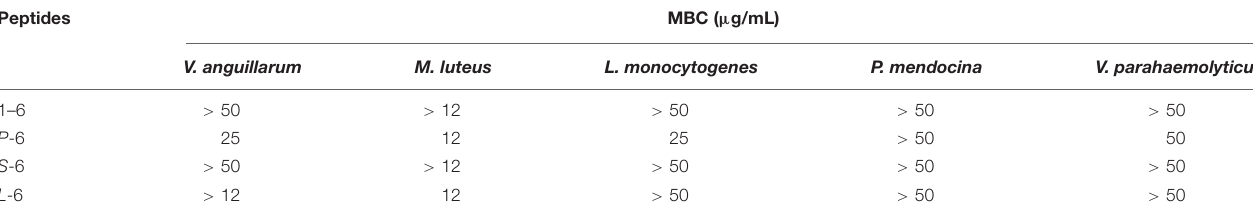
TABLE 2 | Minimum bactericidal concentration (MBC) of four antimicrobial peptides against bacteria. Peptides MBC ( µ